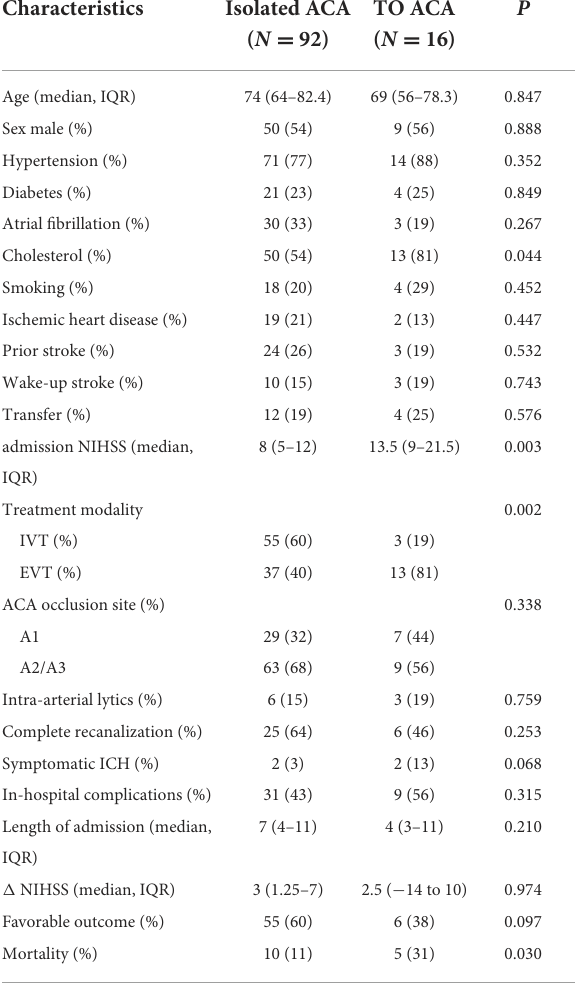
TABLE 1 Characteristics of patients with ACA